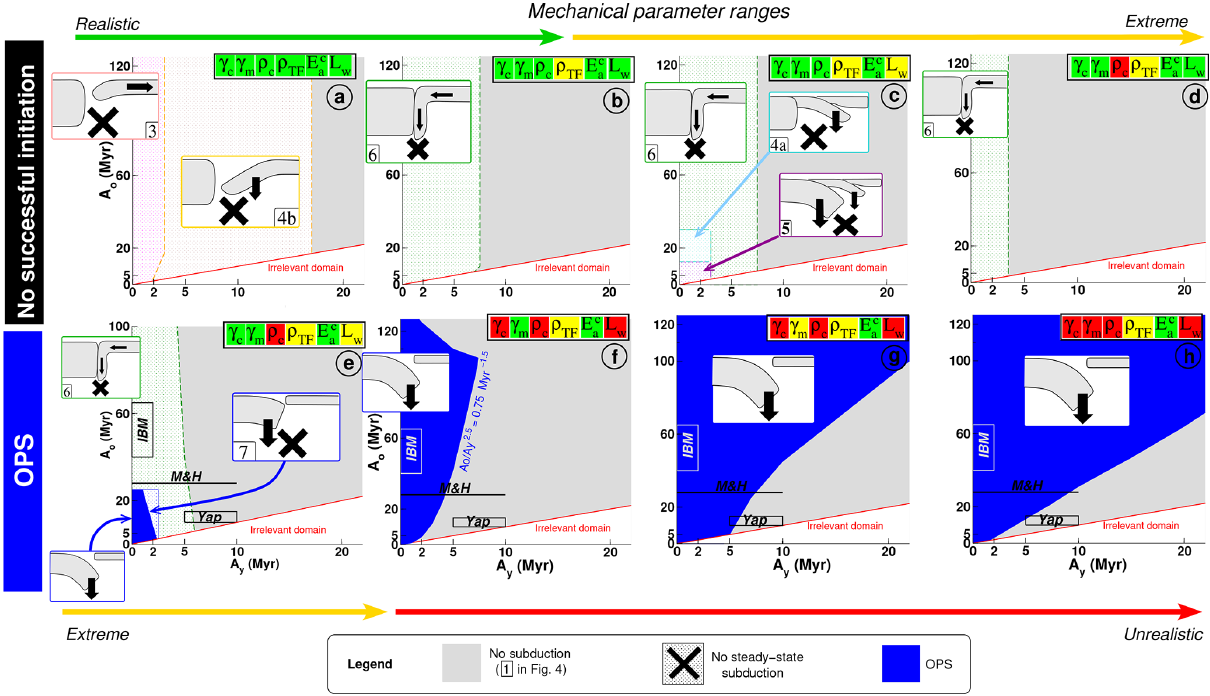
Figure 6. Regime diagrams as a function of the combination of rheological properties, densities, and TF weak domain extent, L w . “Irrelevant domain” would correspond to cases where A y > A o . In dotted areas, only transient behaviors, lasting less than 0.5Myr, are modeled. Inside the inserted sketches, the numbers refer to the panel numbering in Fig. 4. The box colors correspond to parameter ranges depicted in Fig. 3. The parameter combination γ c , γ m , ρ c , ρ TF , and L w , is, respectively, in panel (a) : 0.05, 1.6, 2920, 2920kgm − 3 , and 0km; in panel (b) 0.05, 1.6, 2920kgm − 3 , 3300, and 0km; in panel (c) : 0.05, 1.6, 2920, 3300kgm − 3 , and 50km; in panel (d) : 0.05, 1.6, 3300, 3300kgm − 3 , and 0km; in panel (e) : 0.05, 1.6, 3300, 3300kgm − 3 , and 50km; in panel (f) : 5 × 10 − 4 , 1.6, 3300, 3300kgm − 3 , and 1100km; in panel (g) : 5 × 10 − 4 , 0.1, 3300, 3300kgm − 3 , and 1100km; and in panel (h) : 5 × 10 − 4 , 0.05, 3300, 3300kgm − 3 , and 1100km. In all panels, E c a = 360kJmol − 1 . The corresponding experiments are displayed in Fig. S2 and S3 in the Supplement. In panel (f) , the boundary between the “no subduction” and “OPS” domains corresponds to the relationship A o /A 2 . 5 y (cid:38) 0 . 75Myr − 1 . 5 . When OPS is simulated (panels e to h ), the conditions in A o - A y prevailing at subduction initiation inferred for Yap, IBM, and Matthew and Hunter (Table 1) are superimposed on the regime